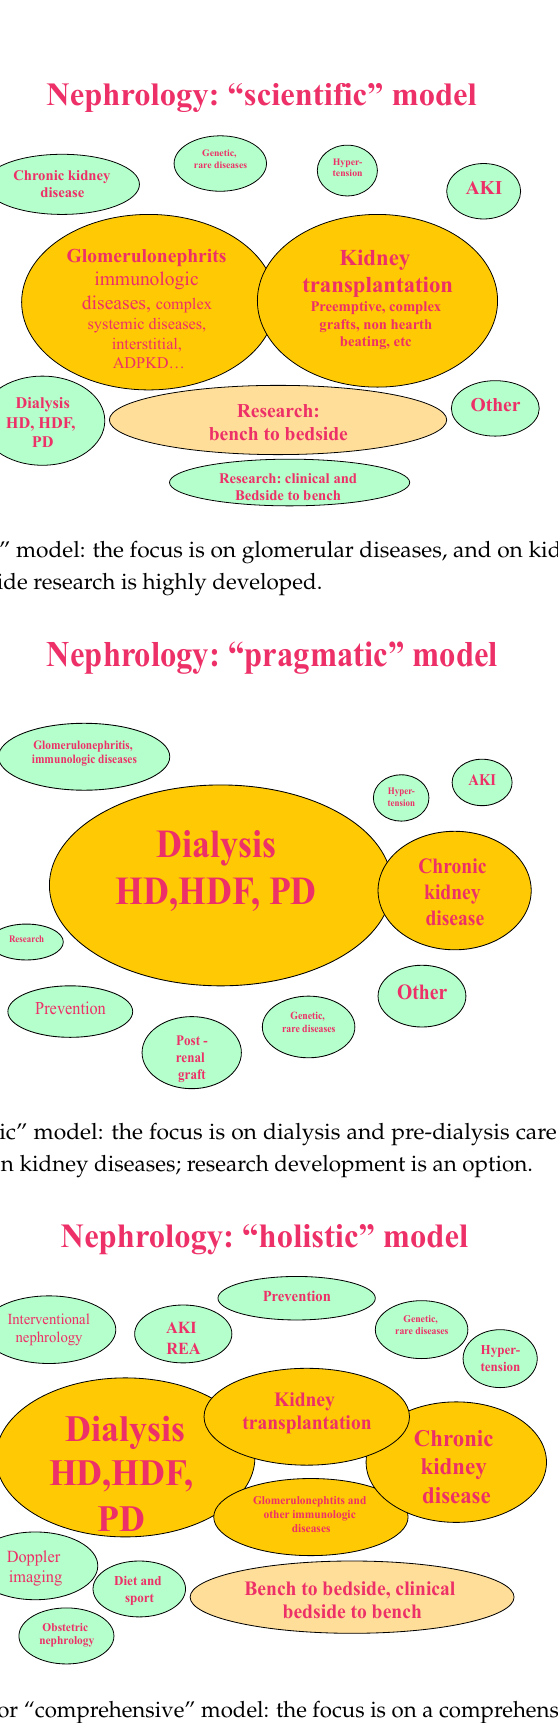
Figure 3. The “holistic” or “comprehensive” model: the focus is on a comprehensive system, in which all aspects of care and research are included.